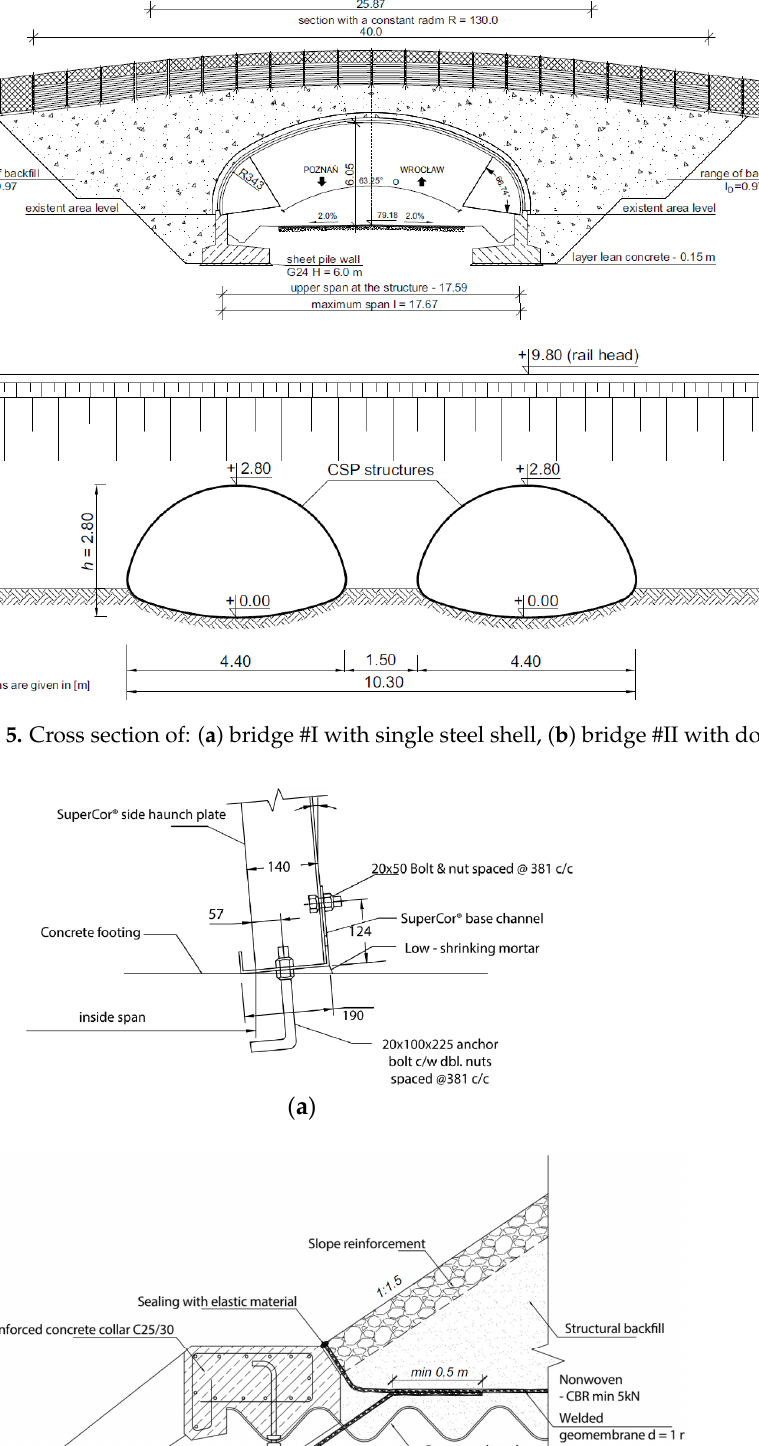
Figure 4. Dimensions of corrugated steel plates of bridge: ( a ) #I and ( b ) #II.